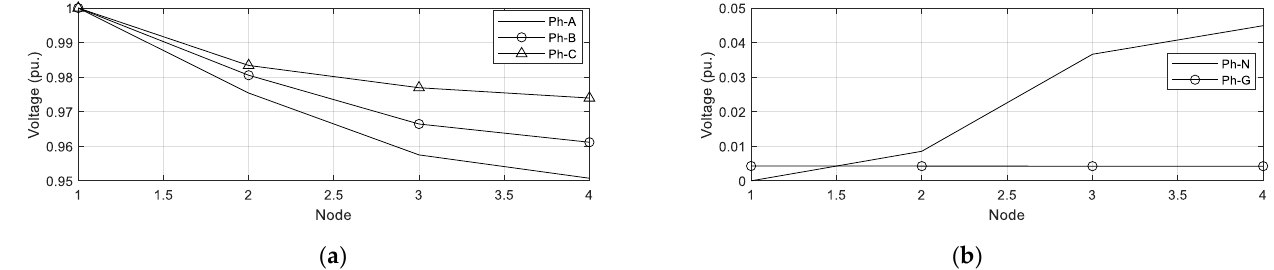
Figure 8. Phase voltage results of ( a ) Phase − A, − B, and − C and ( b ) Phase − N and − G.